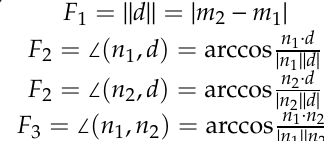
Figure 7. Establishment of feature code database of the wood plank model. 4. Online Calculation Process 4.1. Generating the Feature Code of the Plank to be Grasped Since the stacked wooden planks have obvious hierarchical characteristics, the robot’s grasping process is generally carried out in order from top to bottom, and the wooden plank grasped each time should be the top layer in the scene at that time. First, the Euclidean distance cluster method [41] was used to segment the scene under robot vision, then calculating the average depth of different clusters and selecting the smallest average depth value as the area to be grasped. As shown in Figure 8, there is no need to match all the wood planks in the scene later, which saves on the computing time. Next, we randomly extracted a part of the scene pointpair feature information and the point pair corresponding local image patches from the area to be grasped, and input the local image patches into the trained encoder to generate local image patch feature vectors. These were combined with the pointpair geometric feature information to form a feature description code.